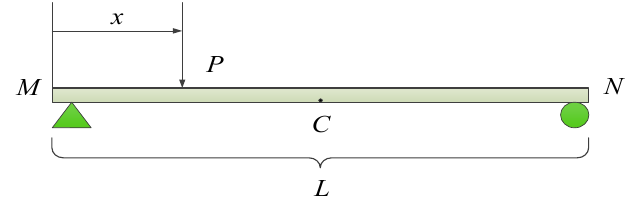
Figure 1. Moving load acting on the simply supported beam.